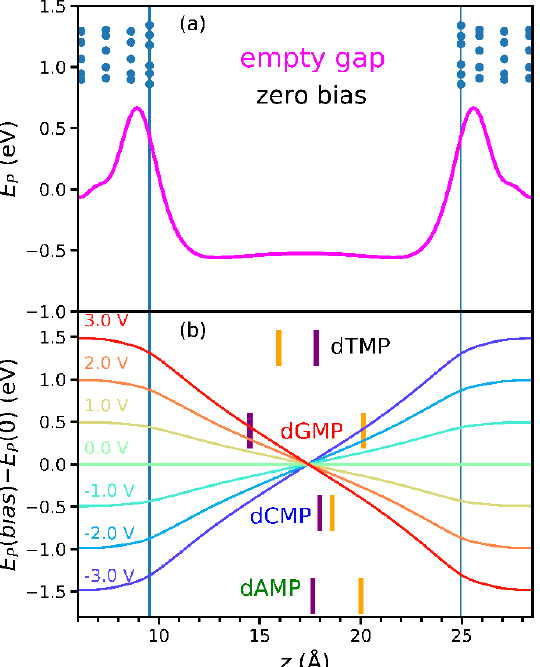
Figure 2. ( a ) The zero-bias electrostatic potential energy E P of an empty gap along the midline in the z -direction. Dots indicate atoms of CNTs, while vertical blue lines denote the gap edges. ( b ) The electrostatic potential energy E P ( bias ) − E P (0) of an empty gap along the midline in the z -direction for several bias values is indicated on the left. Vertical orange and purple lines are the average z coordinates of atoms having the most significant contributions to the nucleotide frontier orbitals HOMO and